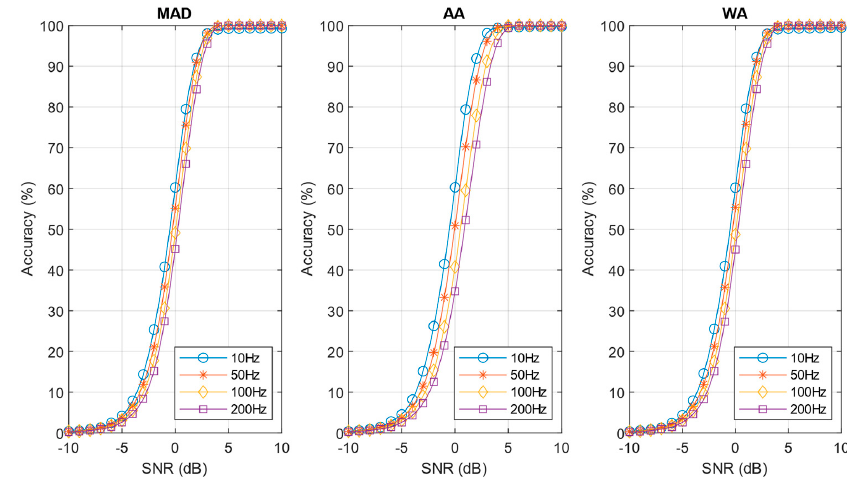
Figure 13. Performances of post-norm algorithm with the investigated noise estimation techniques ( C = 50). Table 1. Detection performances of Standard SNEO at different firing rates at SNR = 0 dB (C = 5).